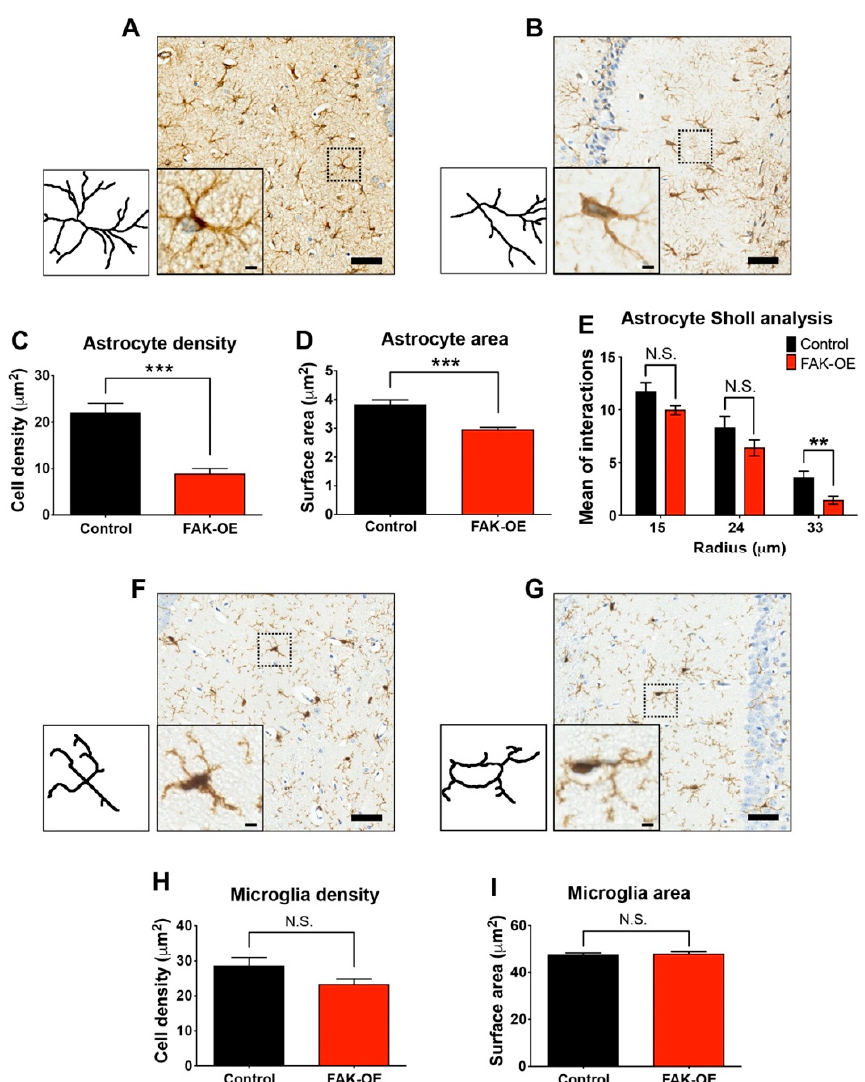
Figure 4. Hippocampal FAK overexpression significantly reduces astrogliosis, but not microgliosis. ( A , B ) Representative 20 × brightfield images of hippocampi CA1 regions from control and FAK-OE mice labeled with anti-GFAP for astrocytes. Insets: Representative astrocytes, left: Respective trace drawings of representative astrocytes shown in insets. Scale bar, 50 µ m (insets: 5 µ m). ( C ) Quantification of astrocyte cell density in hippocampi of control and FAK-OE mice. *** p < 0.001 by unpaired Student’s t -test. ( D ) Quantification of astrocyte surface area *** p < 0.001 by unpaired Student’s t -test. ( E ) Quantification of Sholl interactions between astrocyte processes in 15, 24, and 33 µ m radius from cell center. p = N.S., ** p = 0.0092 by an unpaired Student’s t -test. ( F , G ) Representative 20 × brightfield images of hippocampi CA1 regions from control and FAK-OE mice labeled with anti-Iba1 for microglia. Insets: Representative microglia, left: Respective trace drawings of representative microglia shown in insets. Scale bar, 50 µ m (insets: 5 µ m). ( H ) Quantification of microglia cell density in hippocampi of control and FAK-OE mice. p = N.S. by an unpaired Student’s t -test. ( I ) Quantification of microglia surface area. p = N.S. by an unpaired Student’s t -test. N = 40 fields from three mice in each